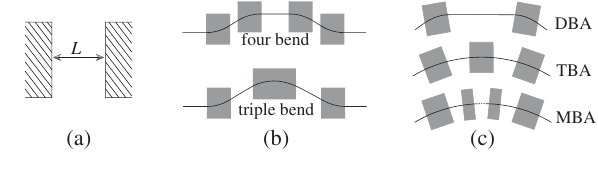
FIG. 12. Three kinds of typical longitudinal drift section. . (b) Four-bend and triple-bend (a) Pure empty space, r 56 ¼ L β 2 c γ 2 c chicane. (c) A series arcs: DBA, TBA,